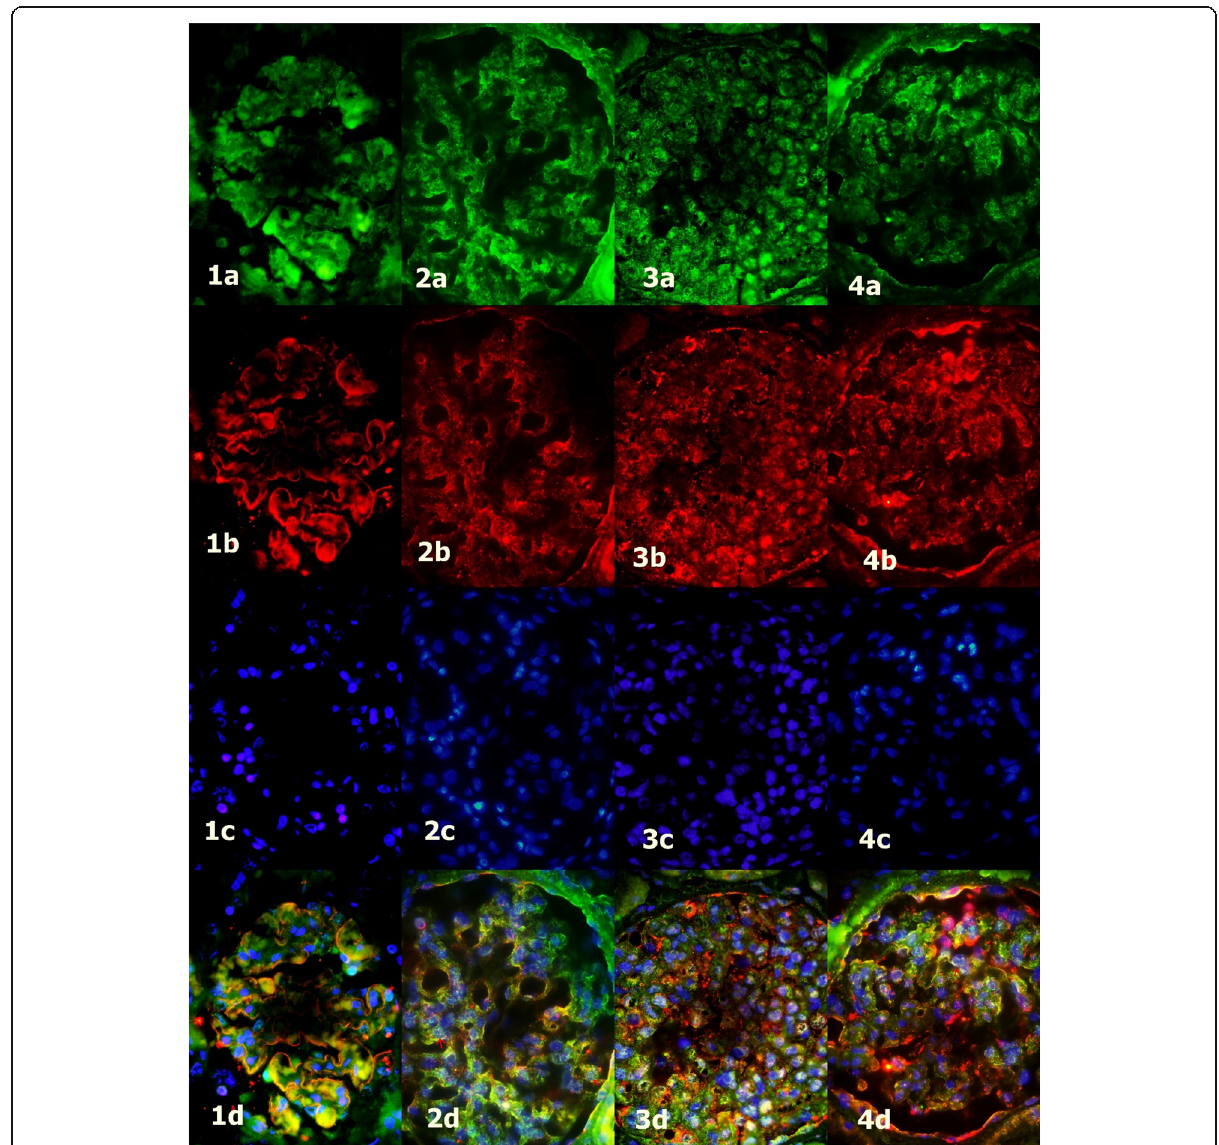
Fig. 1 Nuclear dendrin expression (arrows) in the control group (1) and glomerular diseases (2 - MCD, 3 - IgAN/HSP, 4 - FSGS); a - dendrin (green), b - nephrin (red), c - DAPI (blue), d - merge; fluorescence microscope, immunofluorescence staining, 400